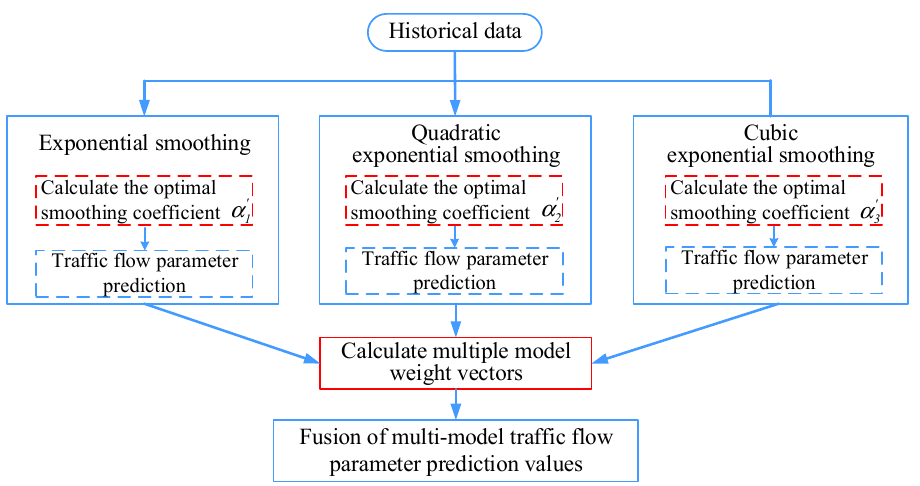
Figure 3. Algorithm concept of dynamic multi-model adaptive exponential smoothing (DMMAES).